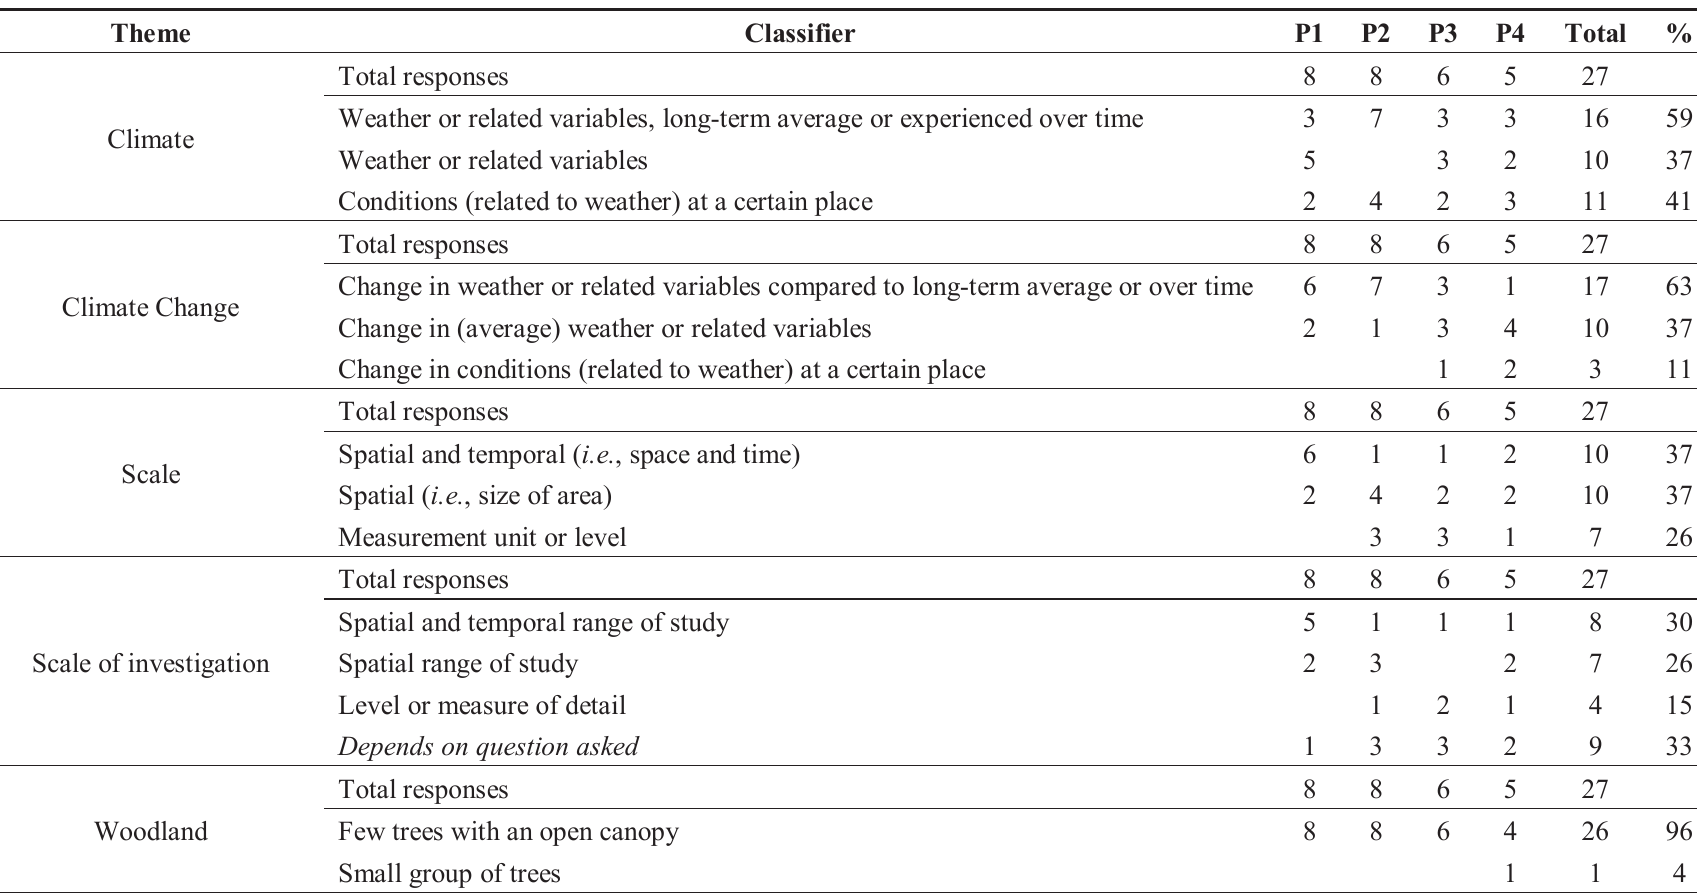
Table 1. Themes and emergent classification derived from the individual responses of the academics working in the centre ( n = 27) Theme: word(s) that were queried. Classifier: words and descriptions used by the respondents in their definition for the themes queried. P1–P4 refers to the individual centre programs. P1: Process and ecosystem modeling, P2: Decline ecology; P3: Restoration ecology; P4: People, policy and implementation. The column indicating the percentage (% = (Total/Total responses) × 100) sometimes exceeds 100% as respondents frequently used multiple